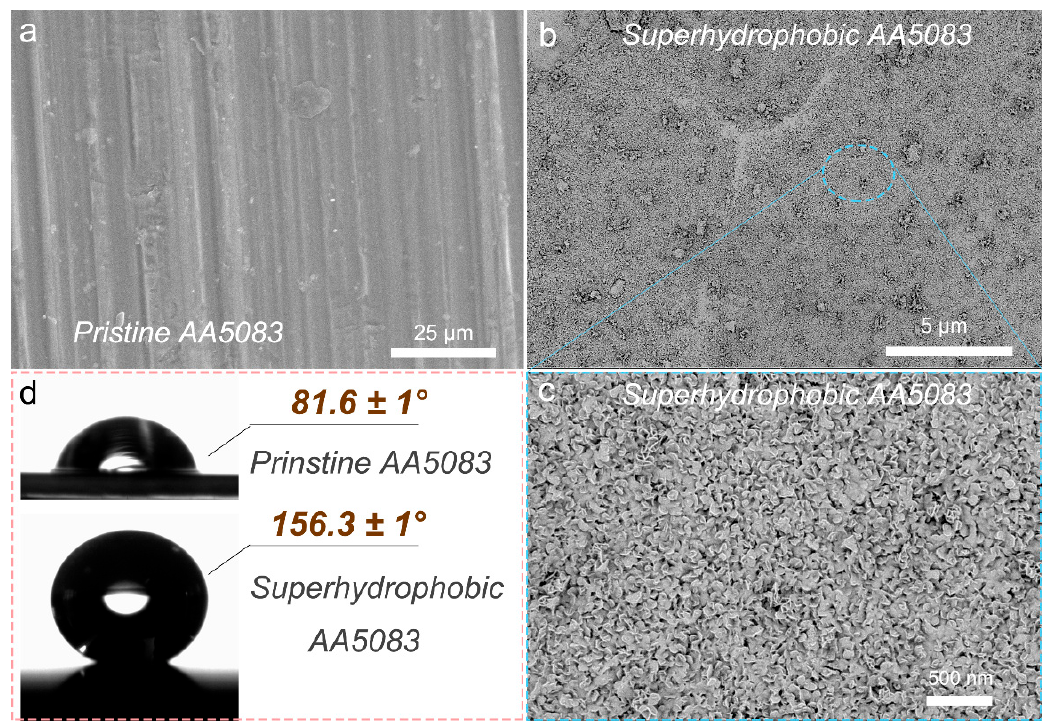
Figure 2. FE-SEM images ( a – c ) and static contact angles ( d ) of pristine 5083 aluminum alloy (AA5083) and as-fabricated superhydrophobic AA5083 surfaces.